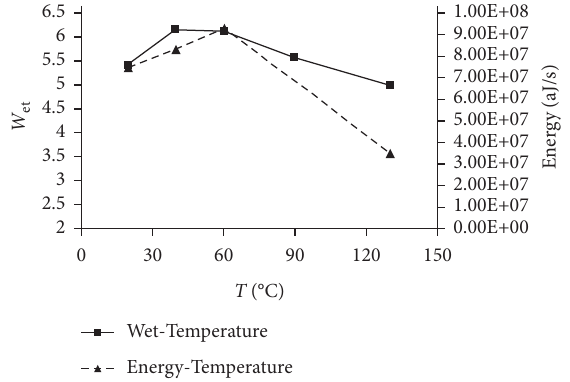
Figure 9: Strain energy storage index W rocks at different temperatures